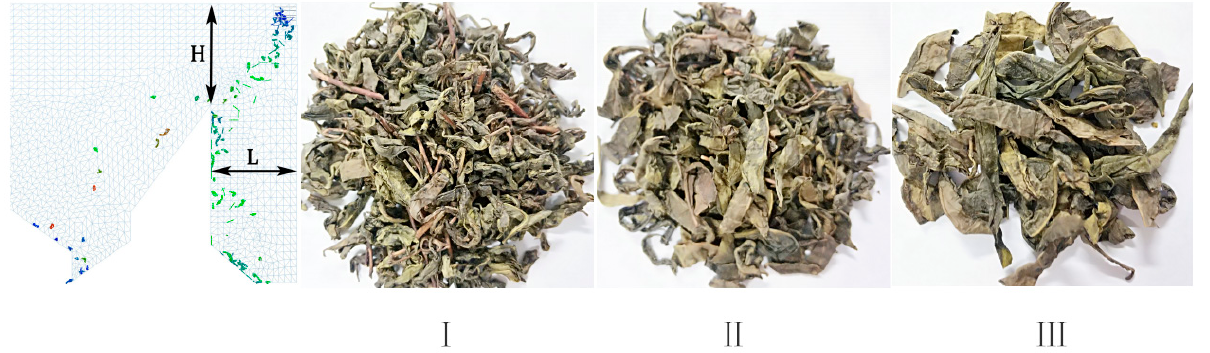
Figure 18. Results of simulation (leftmost panel) and experiments (three right panels). I, II, and III represent collection area.